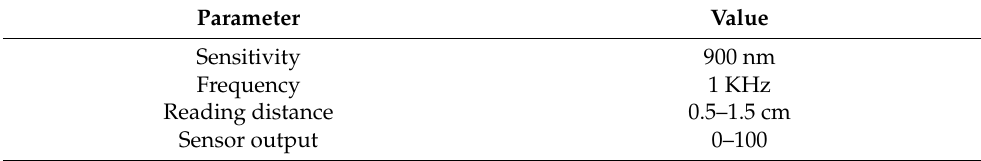
Table 3. General specification parameters for the color sensor.